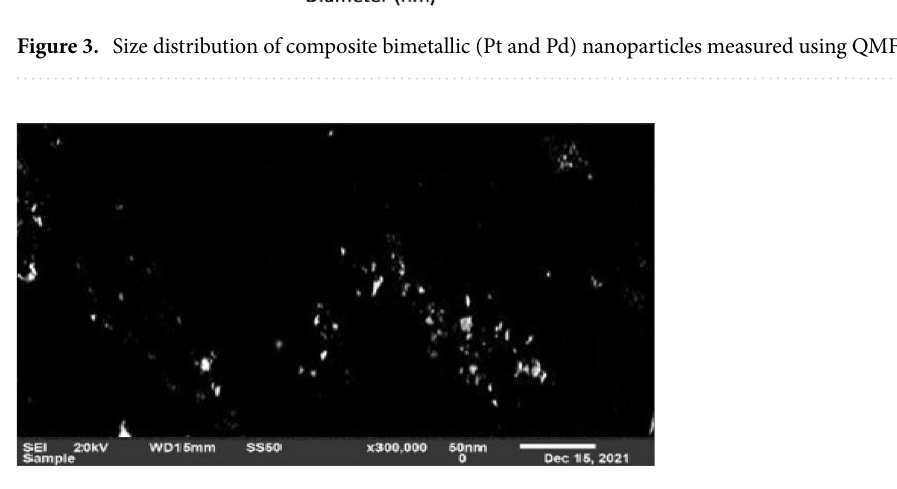
Figure 4. SEM image of bimetallic nanoparticles of palladium and